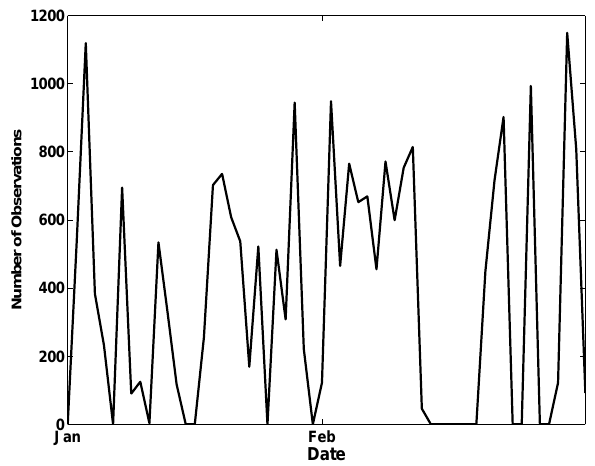
Fig. 2. Daily observation count for clear sky AIRS observations Figure 2: Daily observation count for clear sky AIRS observations used in the data assimilation used in the data assimilation system for January–February 2005, system for Jan-Feb 2005, superobbed to a 2 o × 2 . 5 o grid. superobbed to a 2 ◦ × 2 . 5 ◦